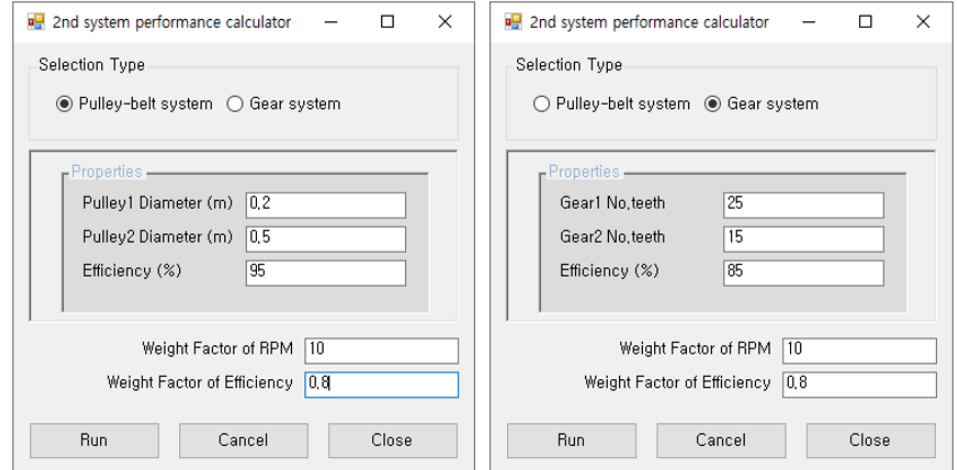
Figure 8. GUI of reliability assessment program of secondary energy conversion mechanical system.